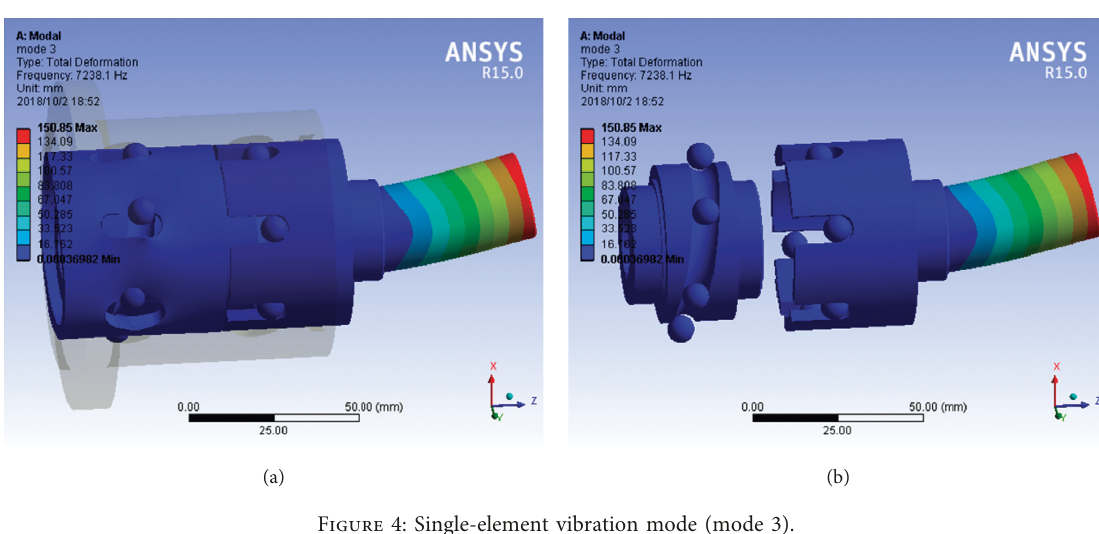
Figure 4: Single-element vibration mode (mode 3).